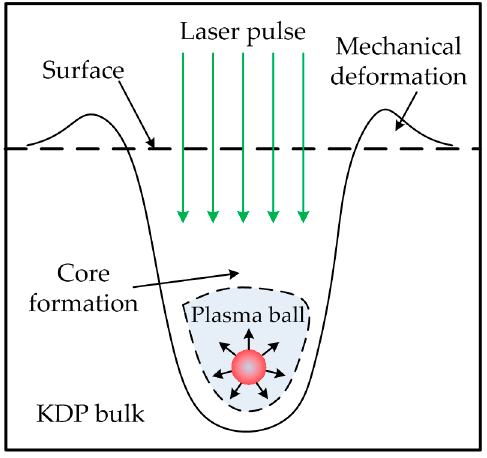
Figure 9. Thermal explosion mechanism of plasma-ball formation around an absorber.